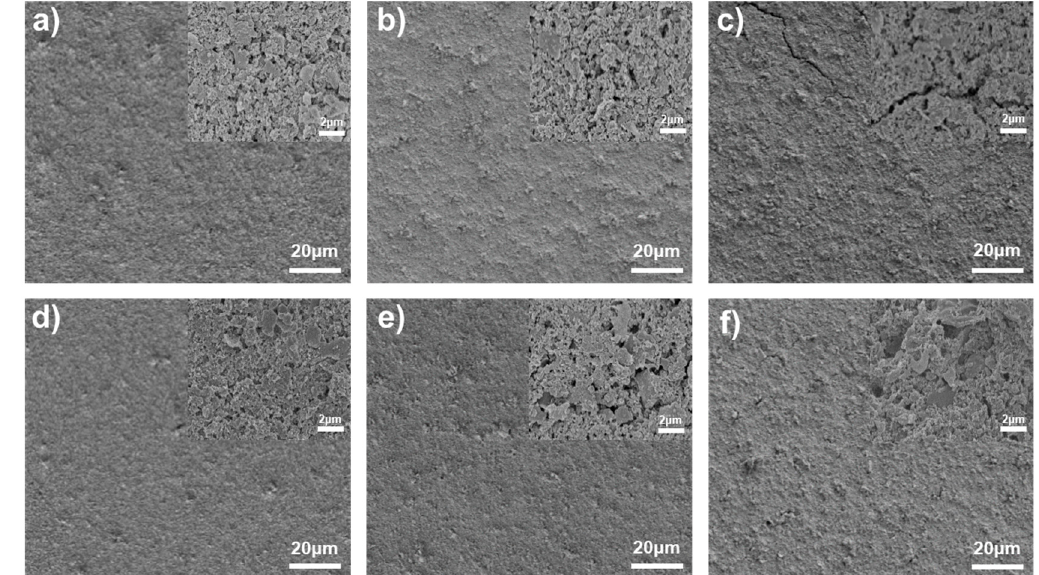
Figure 8. SEM images of untreated h-BN coatings under different deposition conditions. ( a ) 15 V 10 min; ( b ) 30 V 10 min;